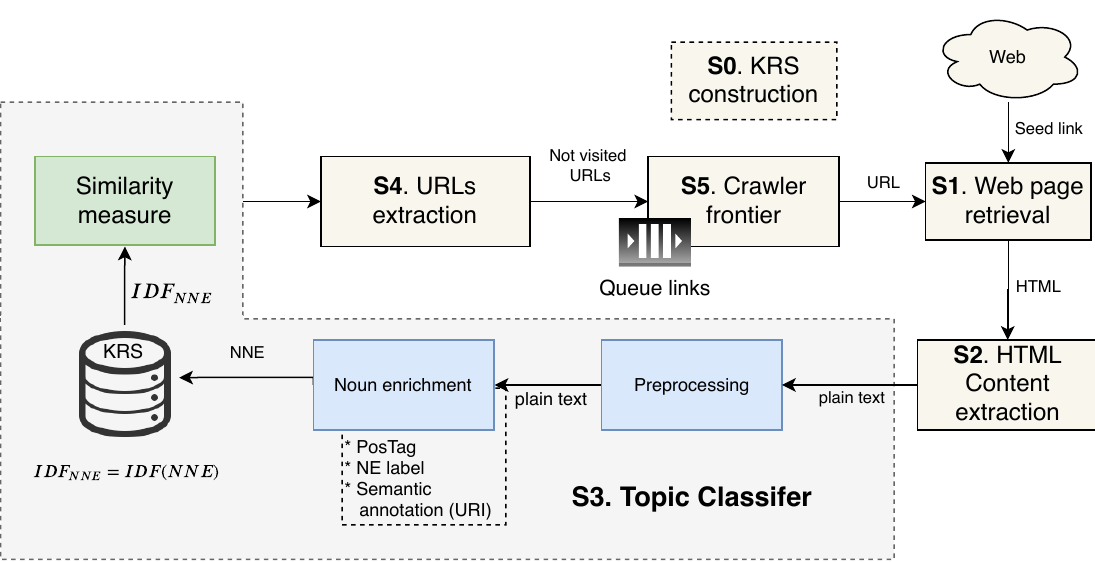
Figure 4. Overview of the proposed